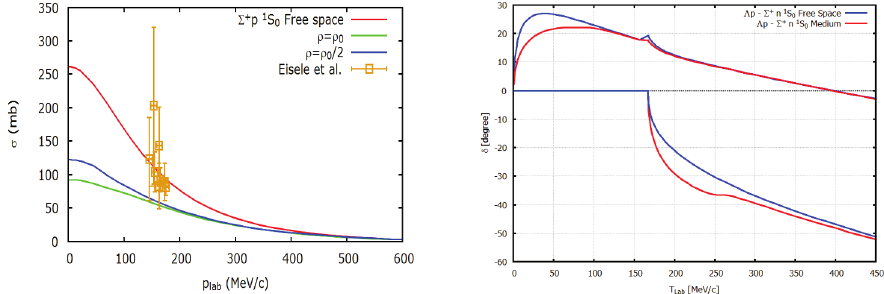
Figure 2. Theoretical integrated Σ + p cross-section for nuclear saturation density and half satura- tion density as a function of laboratory momenta (left) showing signi fi cant medium e ff ect on channel opening ’cusp’ as can be seen in the phase shift plot (right).